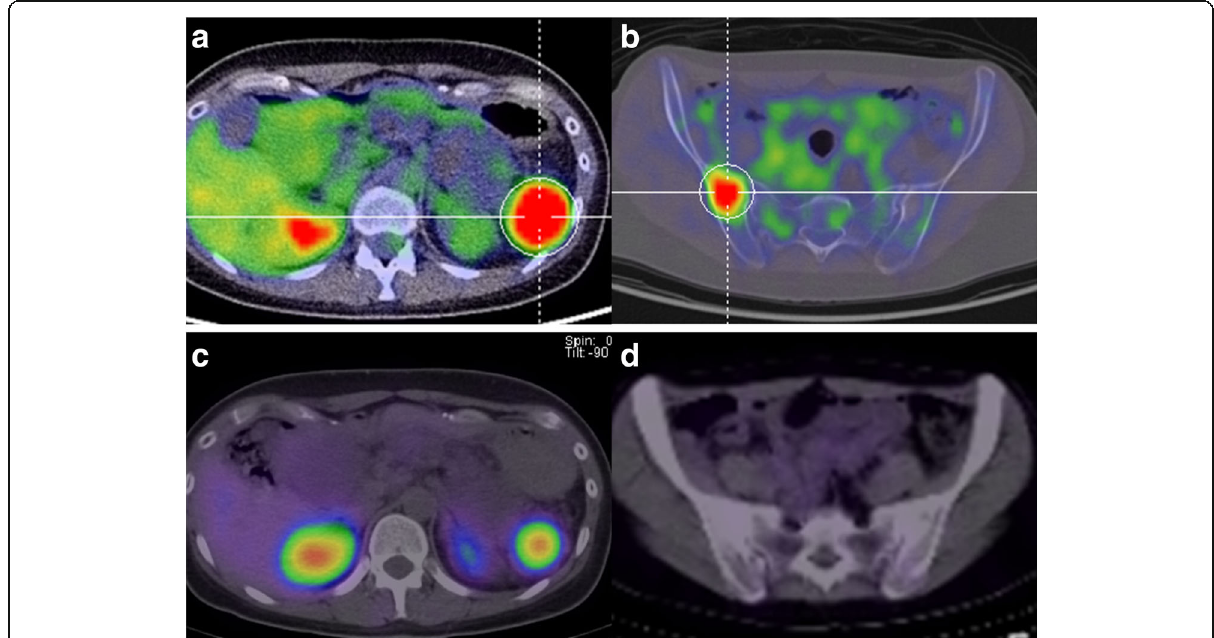
Fig. 3 Fluorodeoxyglucose-positron emission tomography (FDG-PET) demonstrated the accumulation of FDG in a solid tumor in the tail of the pancreas ( a ) and the right ilium ( b ) with a maximum standardized uptake value of 9.5 and 9.4, respectively. Somatostatin receptor scintigraphy showed accumulation of radioactivity in the tumor in the pancreatic tail ( c ) but not in the right ilium ( d )